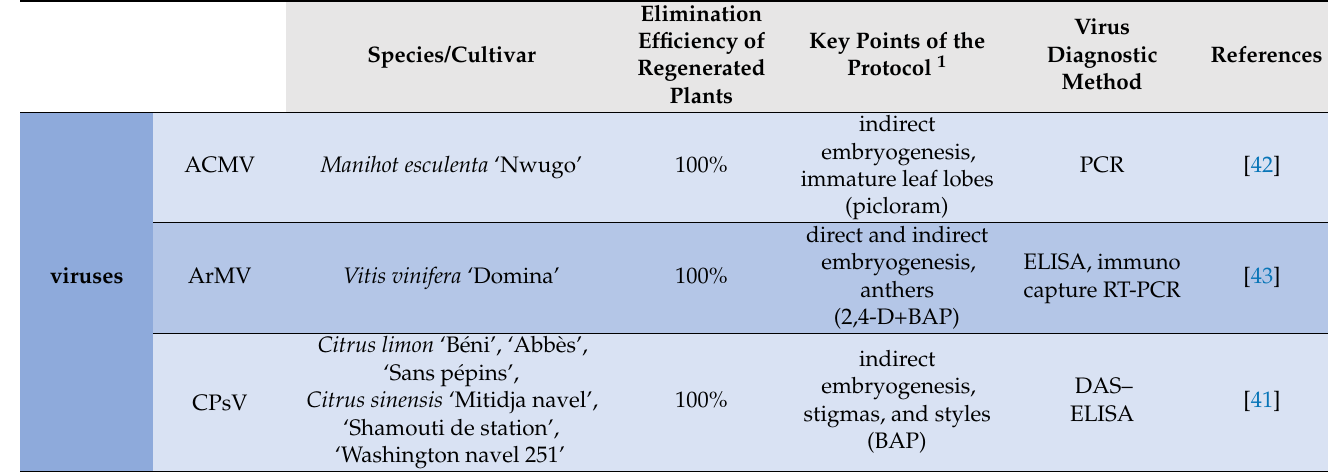
Table 2. Main results of the virus elimination experiments via somatic embryogenesis in different species and